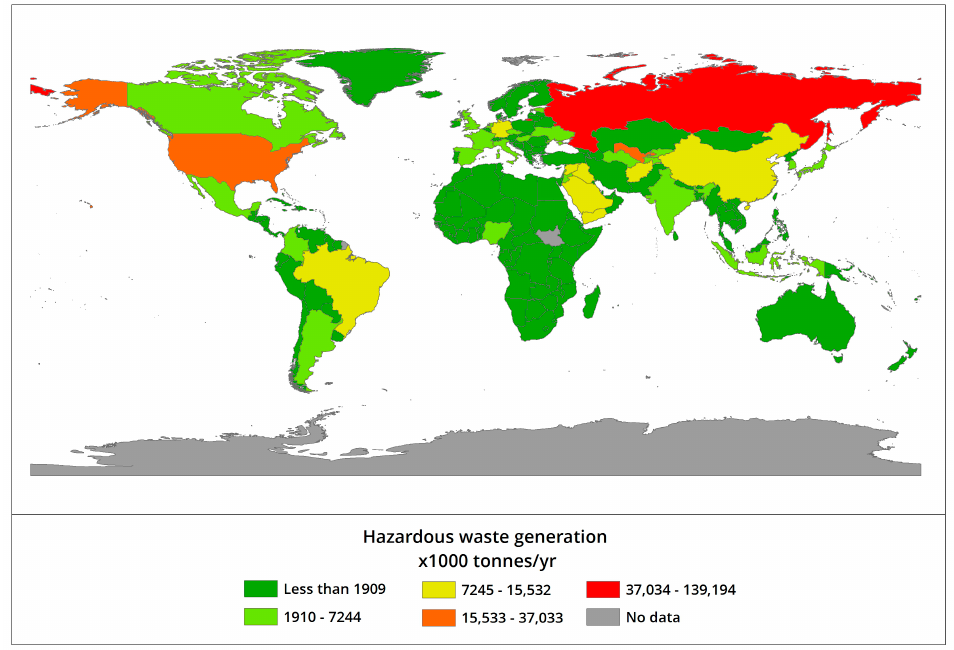
Figure 1. Hazardous Waste Generation. Source: [13].